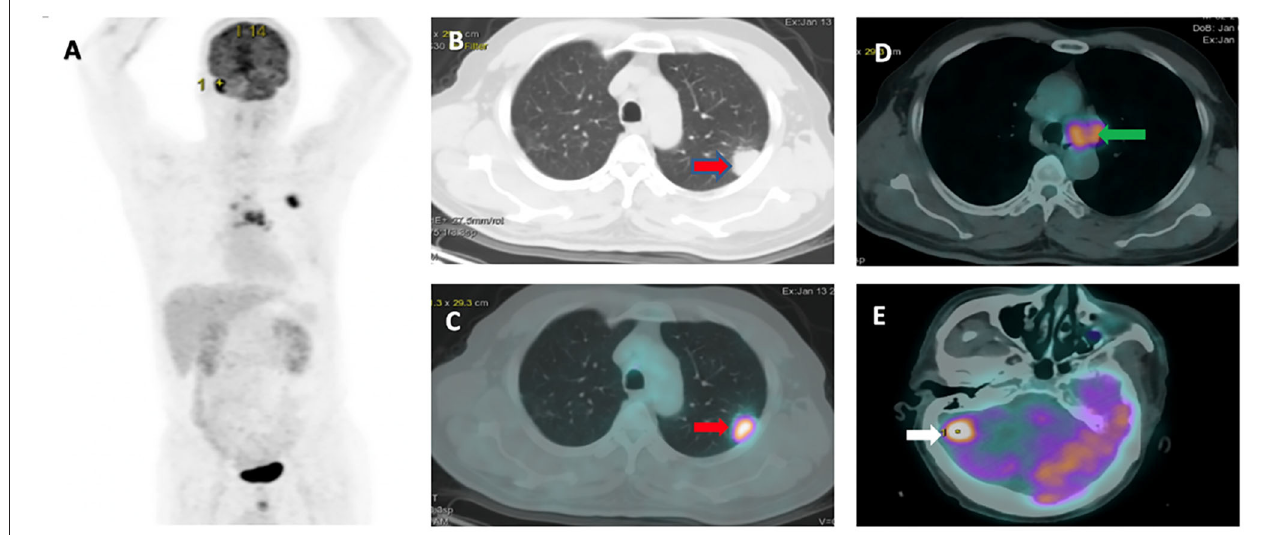
FIGURE 1 | Representative 18 F-FDG PET/CT images: (A) PET image. (B,C) Pleural tumor invasion was detected in the upper left lung with SUV max or 10.17 (red arrow). (D) Mediastinal node metastasis (green arrow ). (E) Brain metastasis (white